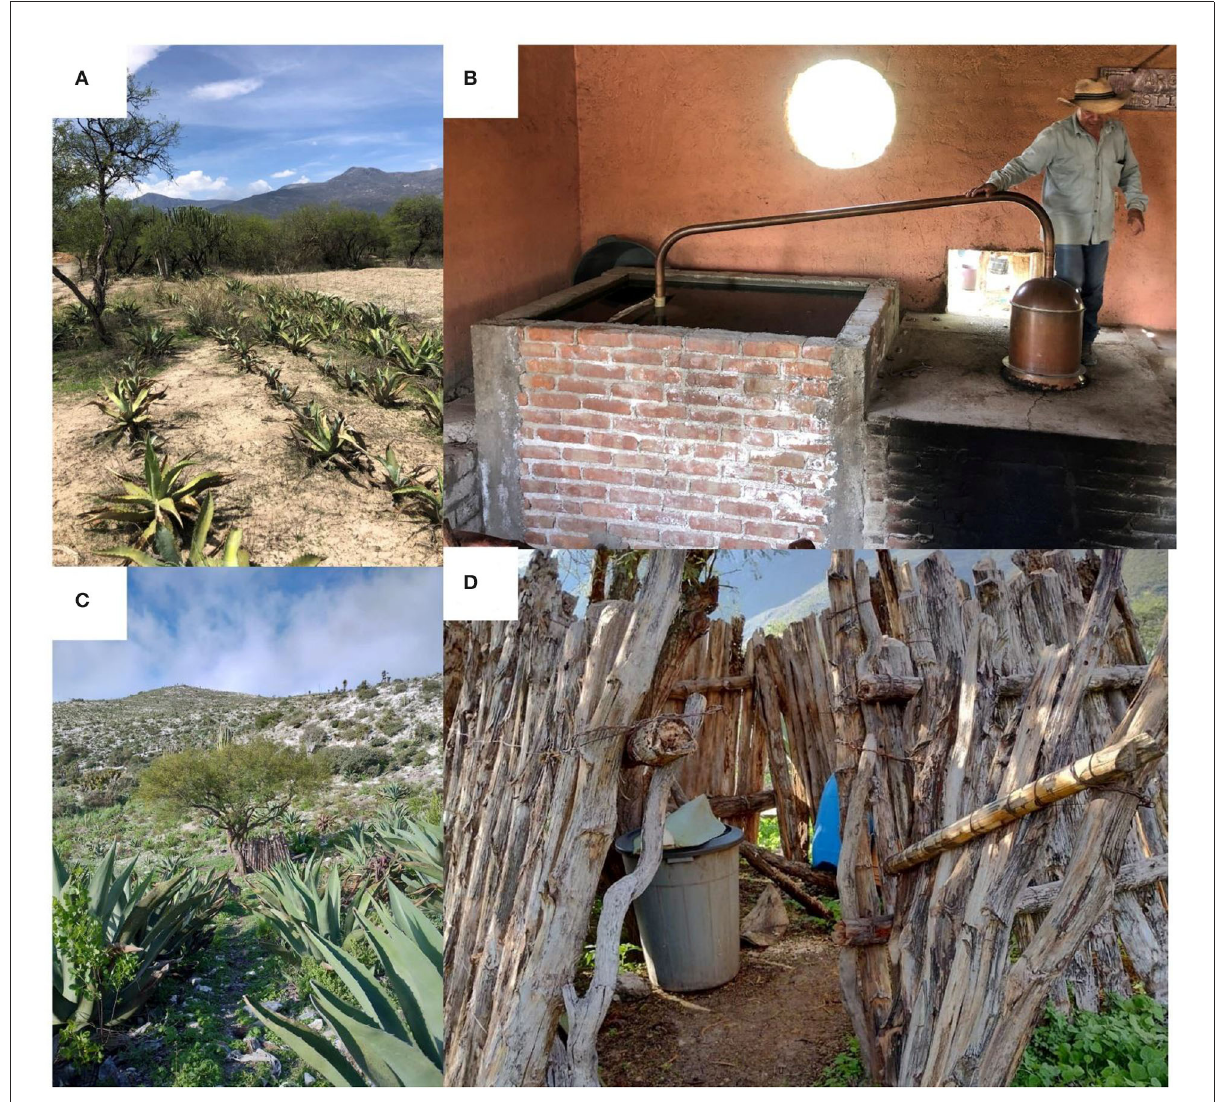
FIGURE2 Mescal and pulque production. (A) A. marmorata cultivars for mescal production closer to the mescal factory. (B) Distillation process in Zapotitlan Salinas, Puebla. (C) A. salmiana cultivar for pulque production. (D) Agave mead storage in plastic container for further pulque